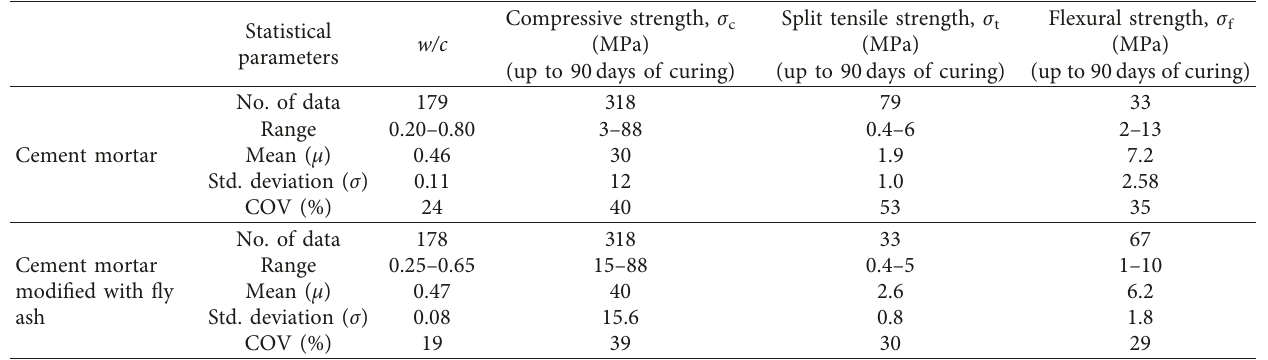
Table 2: Statistical parameters of the properties of cement mortar with and without fly